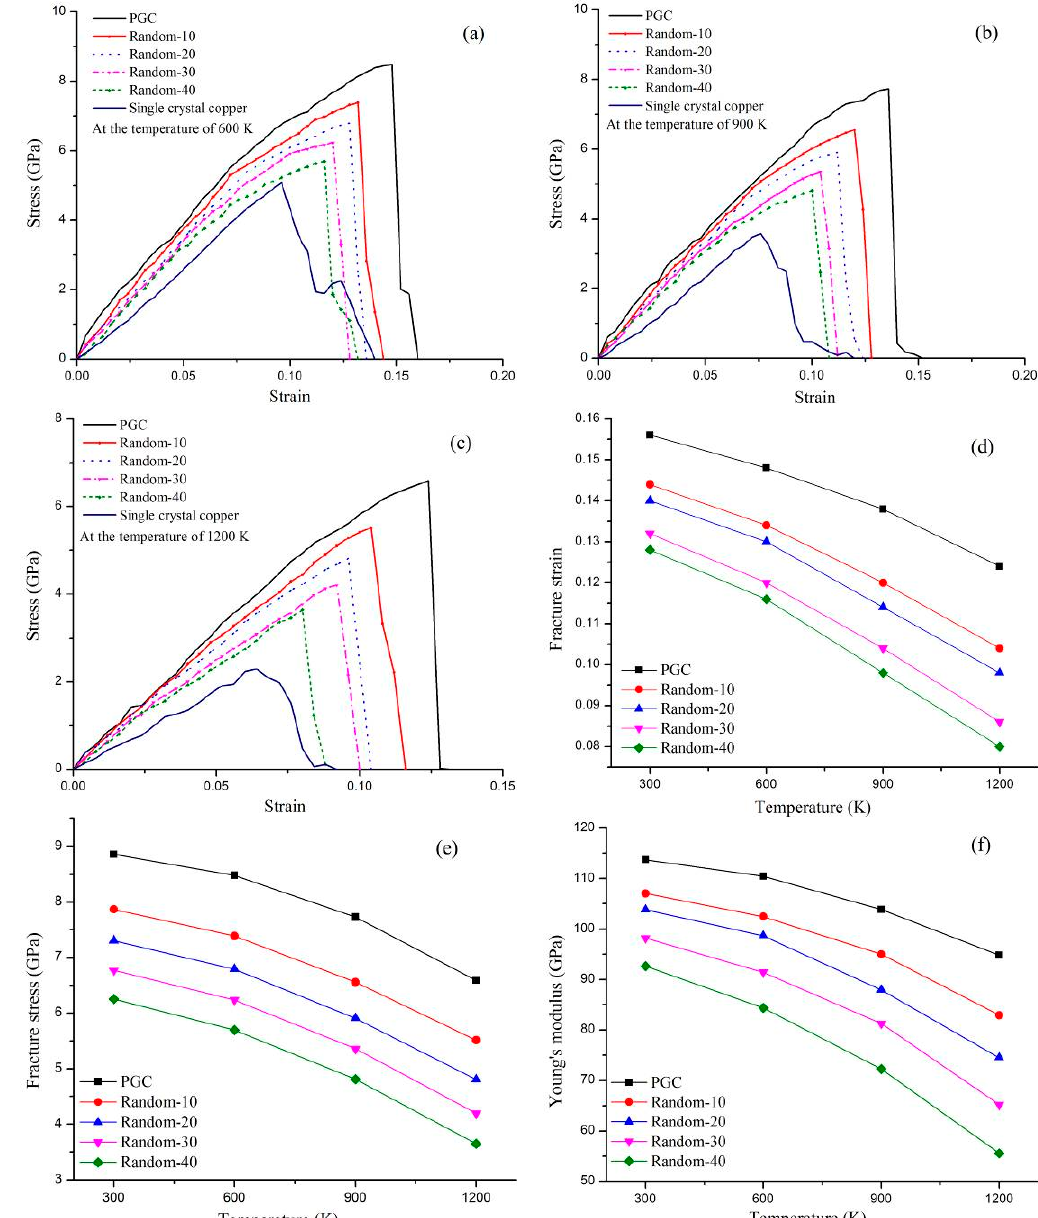
Figure 6. Effect of ion irradiation and temperature coupling on mechanical properties of graphene/copper layered composites in different cases. Stress-strain curve of the simulated model at ( a ) the temperature of 600 K, at ( b ) the temperature of 900 K, and at ( c ) the temperature of 1200 K. ( d – f ) Variations of fracture strain, fracture stress, and Young’s modulus values of graphene/copper layered composites at different temperatures.